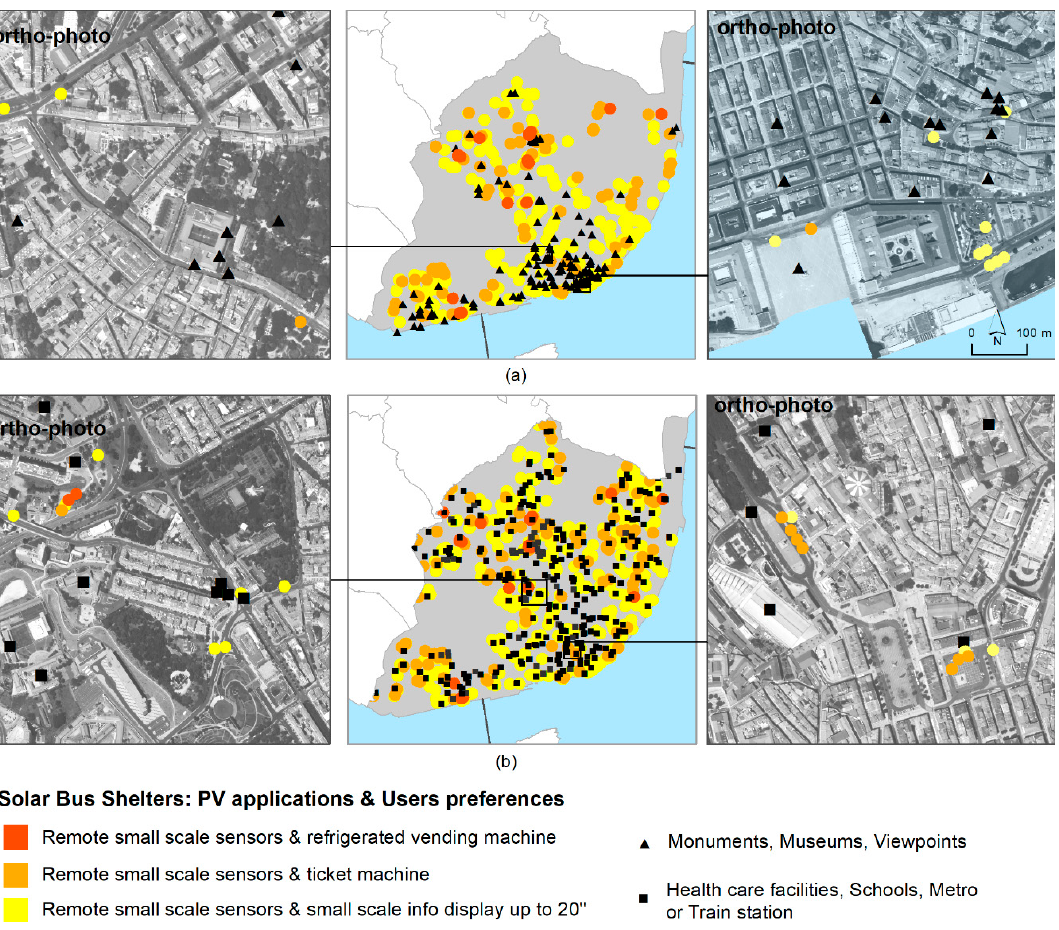
Figure 12. Solar bus shelter locations according to the PV applications and tourist ( a ) and commuter ( b ) preferences.